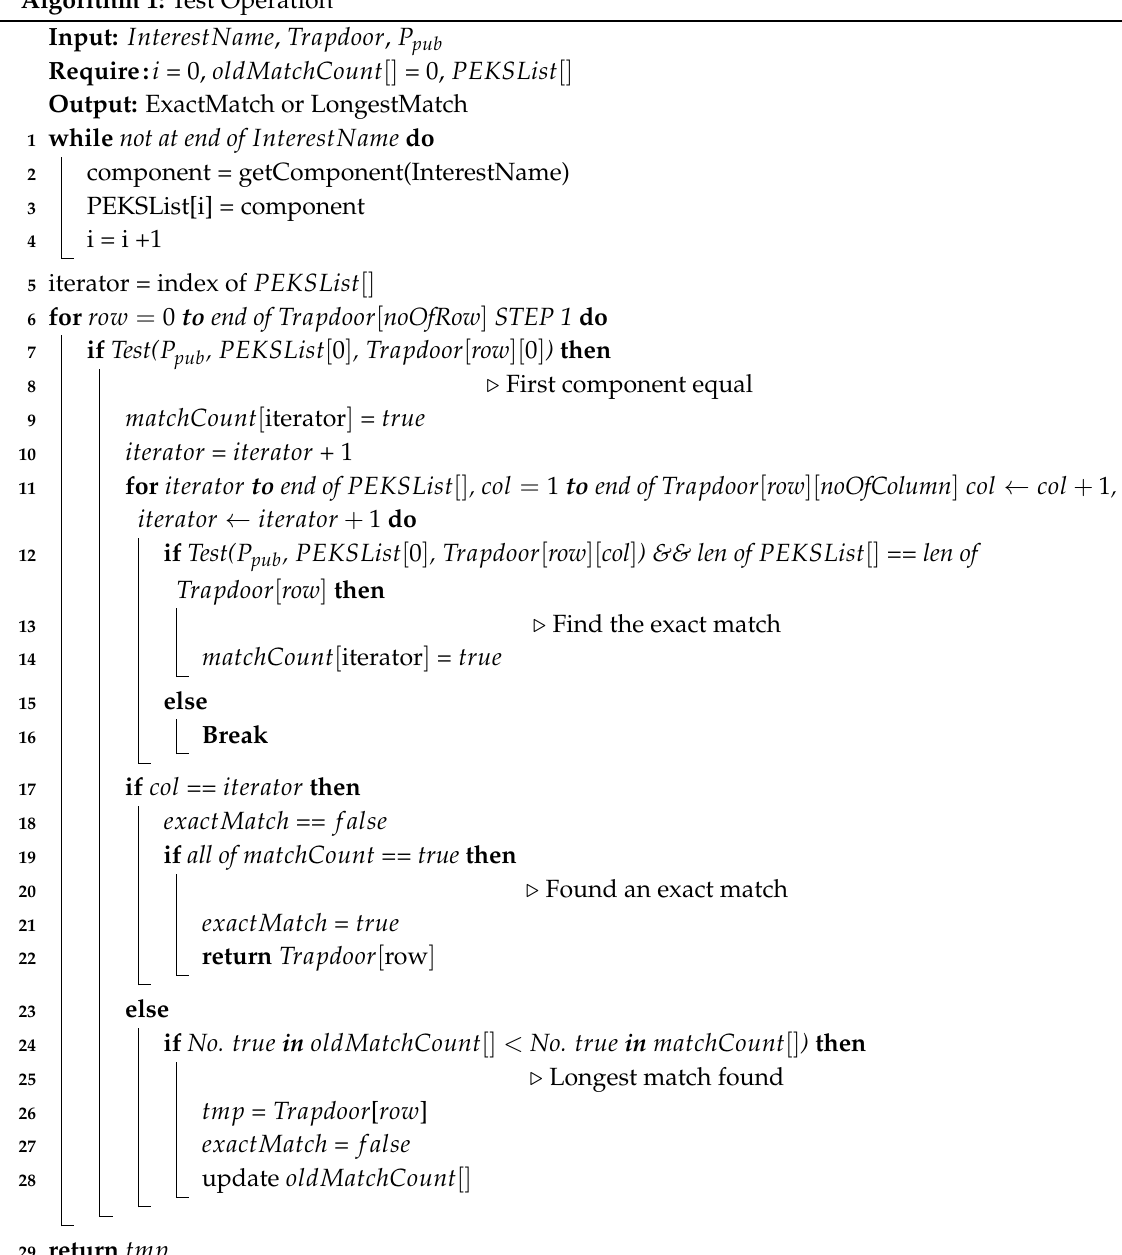
Algorithm 1: Test